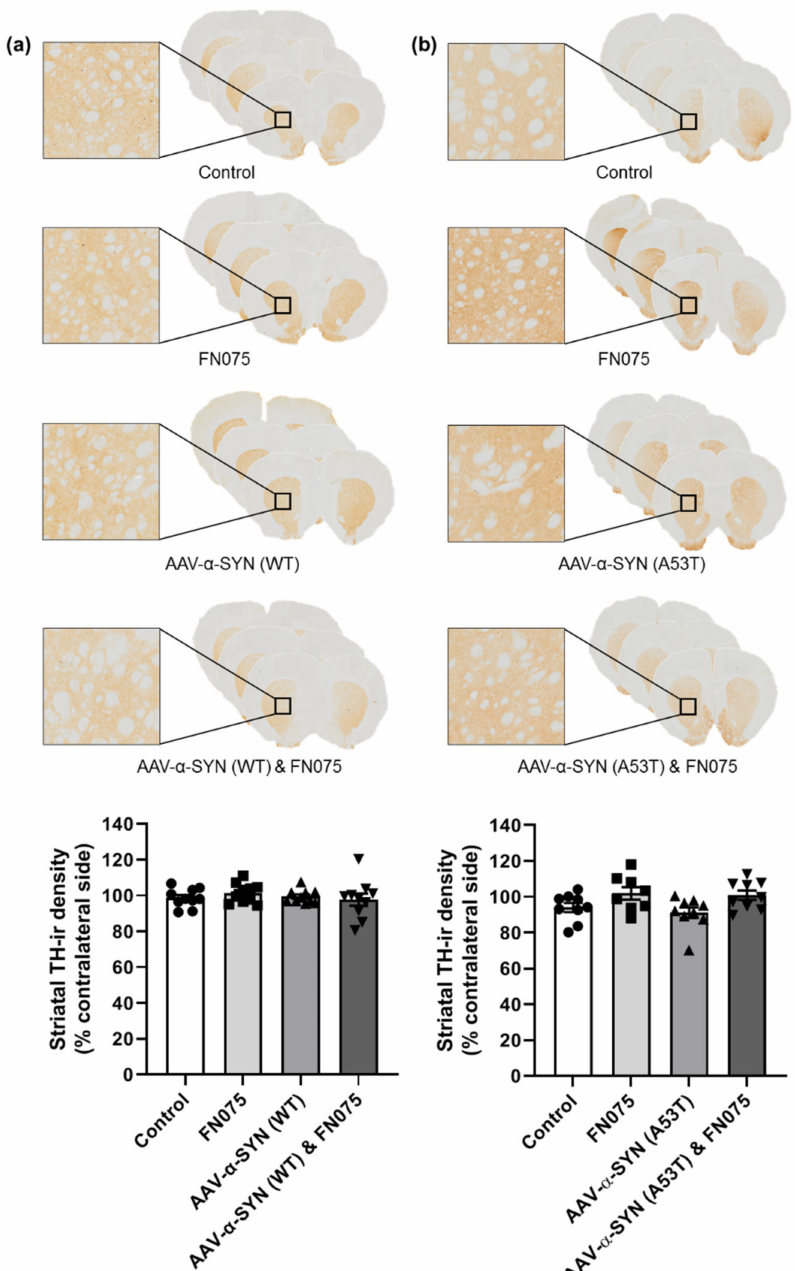
Figure 7. Immunohistological assessment of the impact of AAV- α -synuclein vectors alone or in combination with FN075 on the density of dopaminergic nerve terminals in the striatum. ( a ) AAV- α -SYN (WT) or ( b ) AAV- α -SYN (A53T), either alone or with FN075, did not significantly affect the optical density of TH-immunoreactive staining in the striatum. Data are represented as mean ± SEM with n = 8–10 animals per group by one-way